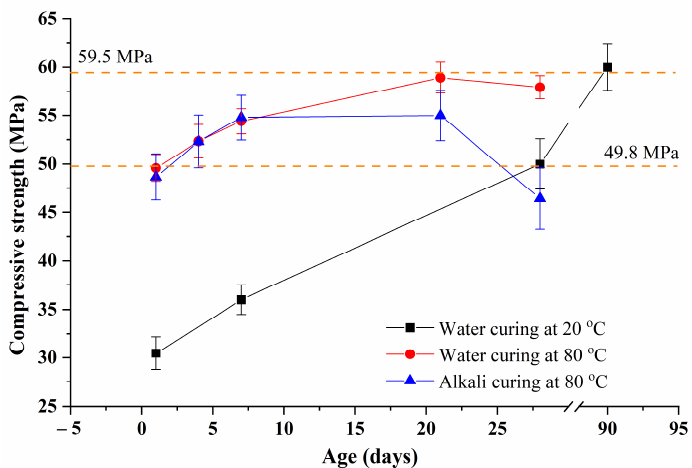
Figure 7. Compressive strengths of the sample Control 0.41 under different conditions.